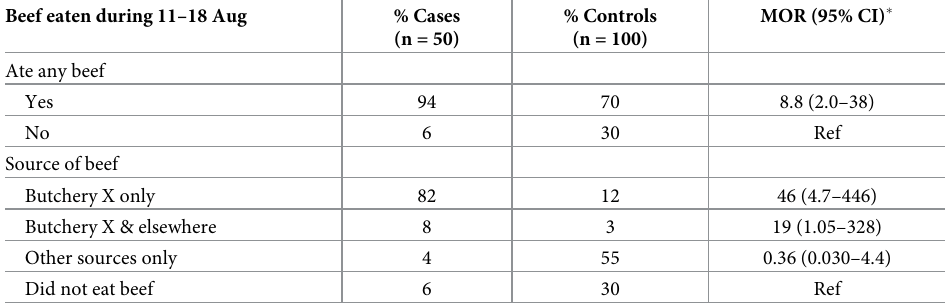
Table 3. Association between source of meat and case status during a suspected gastrointestinal anthrax outbreak: Isingiro, Uganda, August 2017. Beef eaten during 11–18